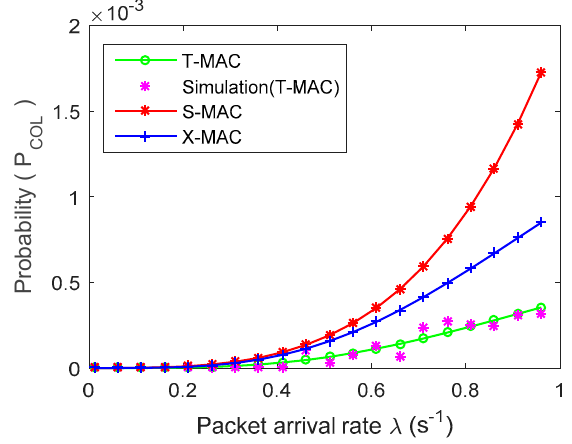
Figure 3. The collision probability 𝑃 (cid:3004)(cid:3016)(cid:3013) in a cycle versus the packet arrival rate ⋋ for the T-MAC, S-MAC and X-MAC protocols.